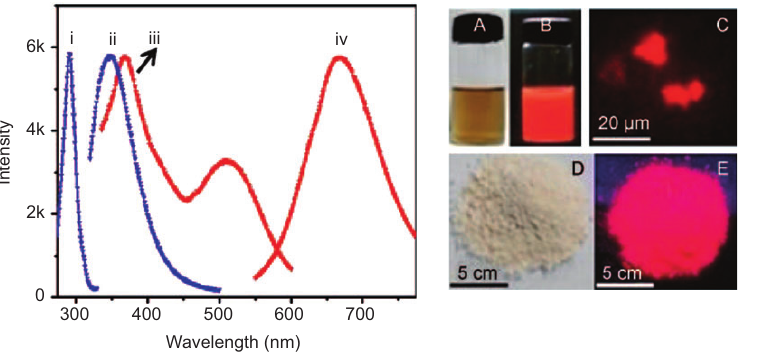
Figure 5 (Left) Photoluminescence profiles of BSA (traces i and ii) and BSA protected gold quantum clusters (AuQC@BSA) (traces iii and iv). (Right) photographs of AuQC@BSA solution under white light (A) and UV light (B), confocal luminescence image of the QC (C), and photo- graphs of QC powder under irradiation by white light (D) and UV light (E). From Ref. [80] .